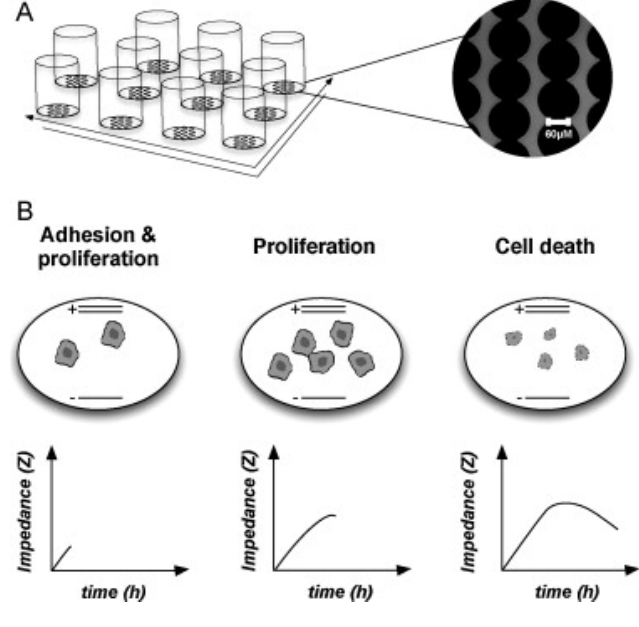
Figure 5. Schematic overview of the measurement principle of cellular impedance. ( A ) Each well of the culture dish features a bottom with embedded gold-electrodes. The electrode array has a minimal distance of 30 μ m between the electrodes. The right picture shows an upright view of the electrode array. ( B ) Cells were seeded on top of the electrode-covered surface of the culture dish. After attaching to the bottom of the well, the cells partially insulate the electrodes, causing a rise in impedance. With an increasing cell density, the cells have a greater overall insulating capacity, showing in a further increase in impedance. Inflicting cellular damage and cell death causes changes in membrane morphology, cellular shrinkage, and detachment, resulting in a decrease of the cellular impedance. (Copyright 2012. Reprinted from [31] with permission from